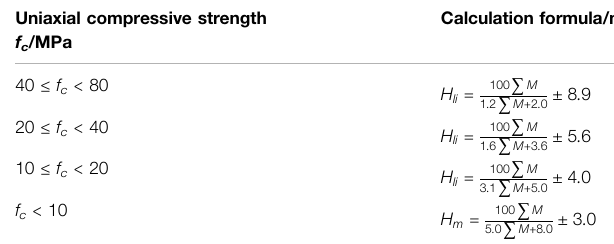
TABLE 3 | The formula for calculating the height of the water-conducting fracture